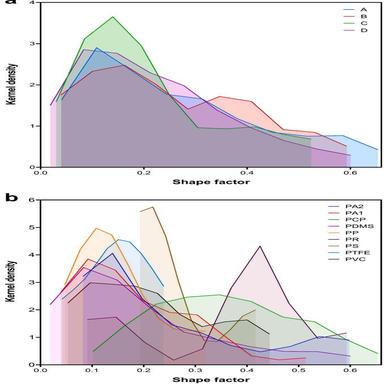
The Kernel Density Estimate (KDE) is employed to represent the distribution of MPs discharged from the IV delivery system in terms of their twodimensional shape factor or circularity. The first plot (a) depicts a range of origins for MP (A = A1-A4, B = B1-B4, C=C1-C4, D=D1-D4), whereas the subsequent plot (b) presents diverse classifications of polymer compositions.